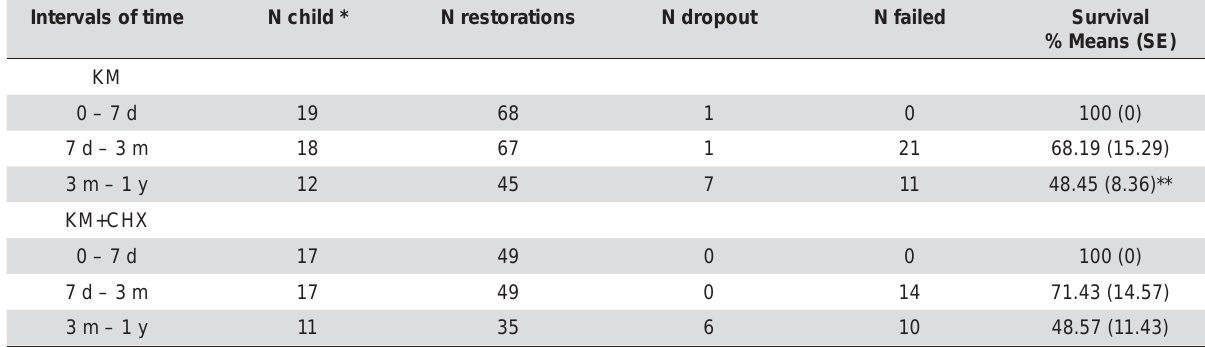
Table 3- Cumulative survival (means - %) and standard error of the means (SE) of ART restorations in primary molars treated with glass ionomer cements containing or not chlorhexidine